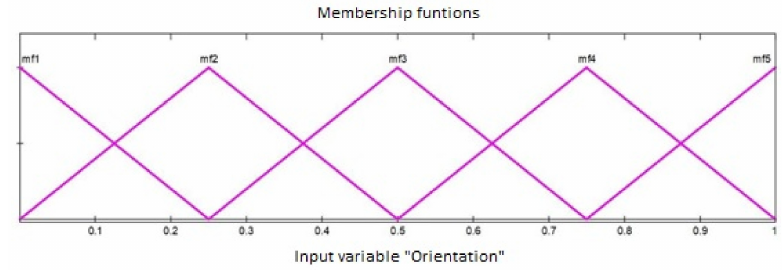
Figure 13. MFs of the input variable “Orientation”. Road access